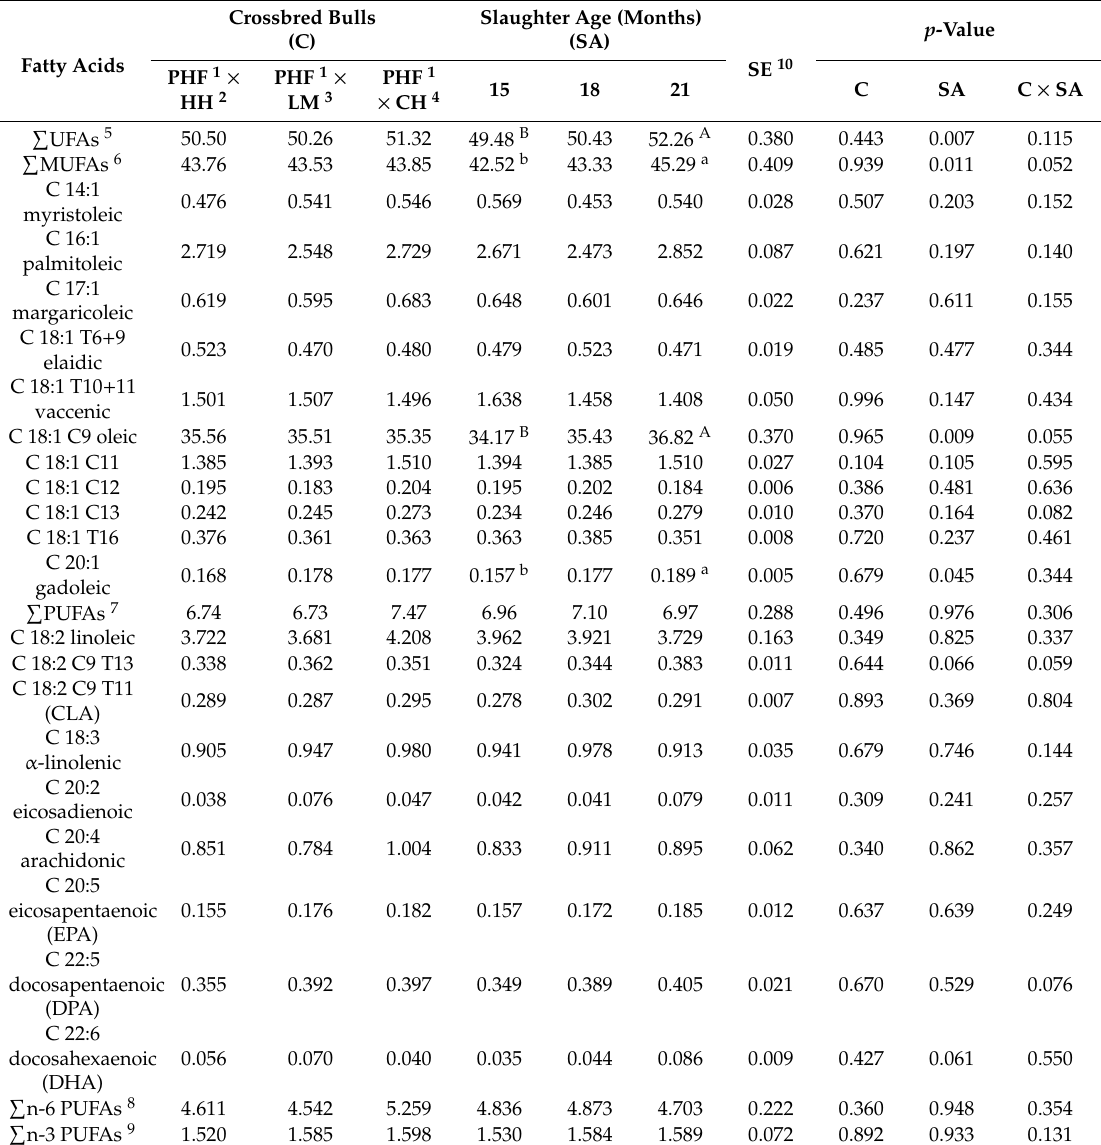
Table 6. Content of unsaturated fatty acids (%) in the longissimus thoracis muscle of crossbred bulls. Crossbred Bulls (C) Fatty Acids